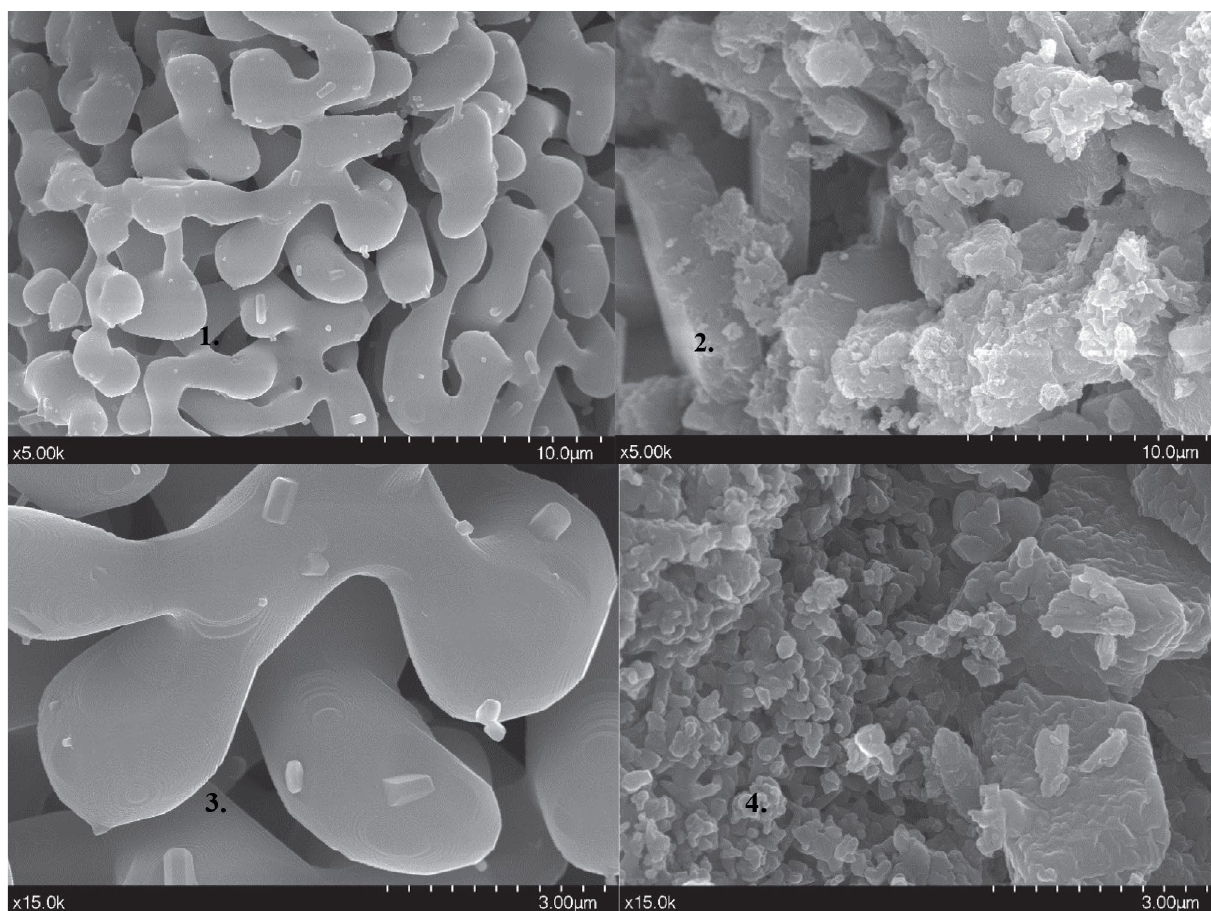
Figure 8. SEM (1, 3) control and (2, 4) 2 g/L RBV-5R dye adsorbed calcined